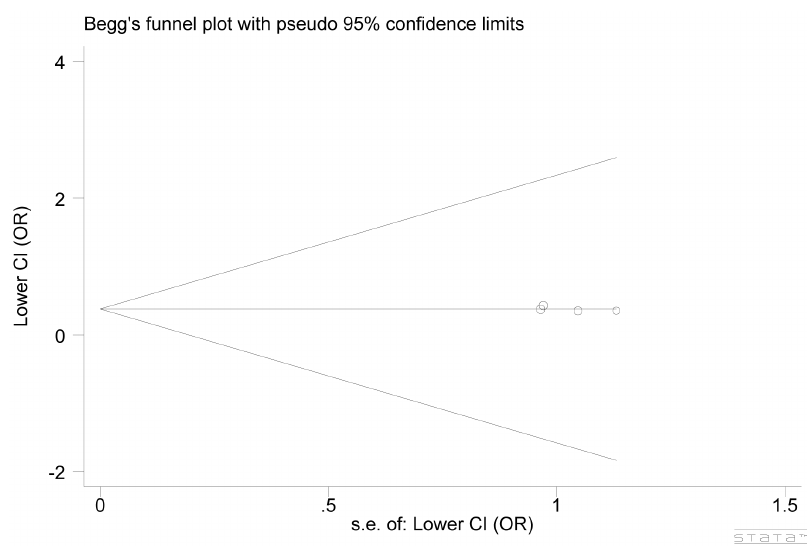
Figure 2. Funnel plot of publication bias analysis for the associations between CD86 polymorphism and cancer risk.